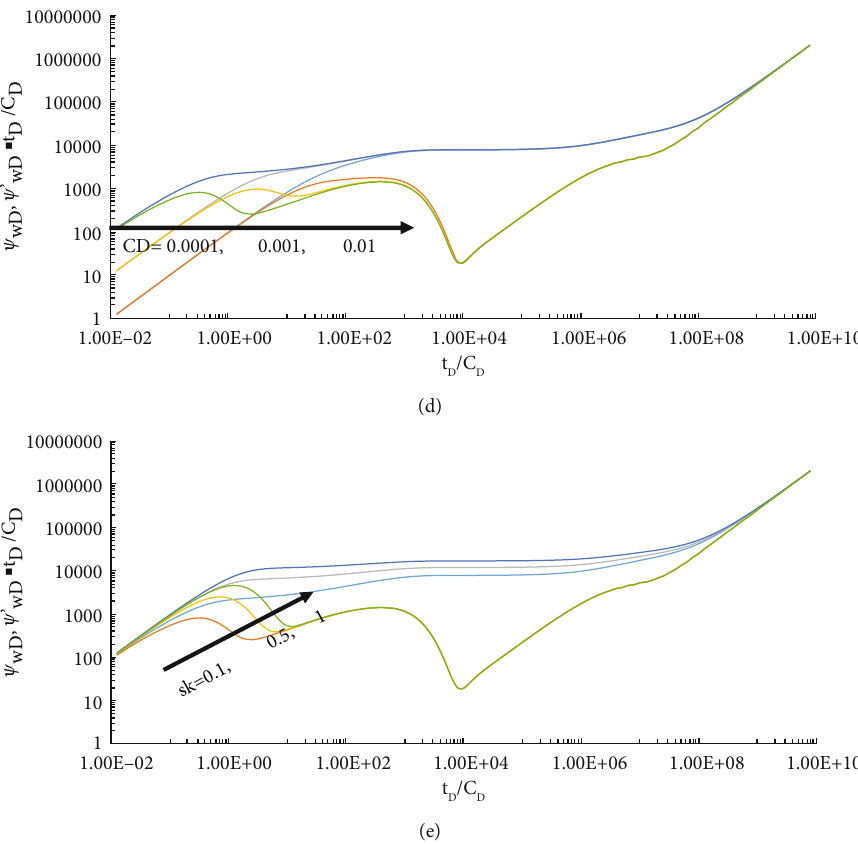
Figure 5: (a) In fl uence of cross- fl ow coe ffi cient on the pseudopressure and pseudopressure derivative. (b) In fl uence of storage ratio on the pseudopressure and pseudopressure derivative. (c) In fl uence of desorption constant on the pseudopressure and pseudopressure derivative. (d) In fl uence of well storage coe ffi cient on the pseudopressure and pseudopressure derivative. (e) In fl uence of skin coe ffi cient on the pseudopressure and pseudopressure derivative.